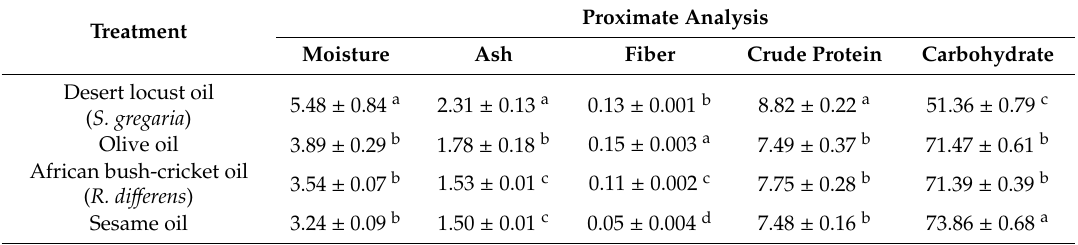
Table 4. Proximate analysis (% dry matter) * of cookies prepared using di ff erent oil sources.